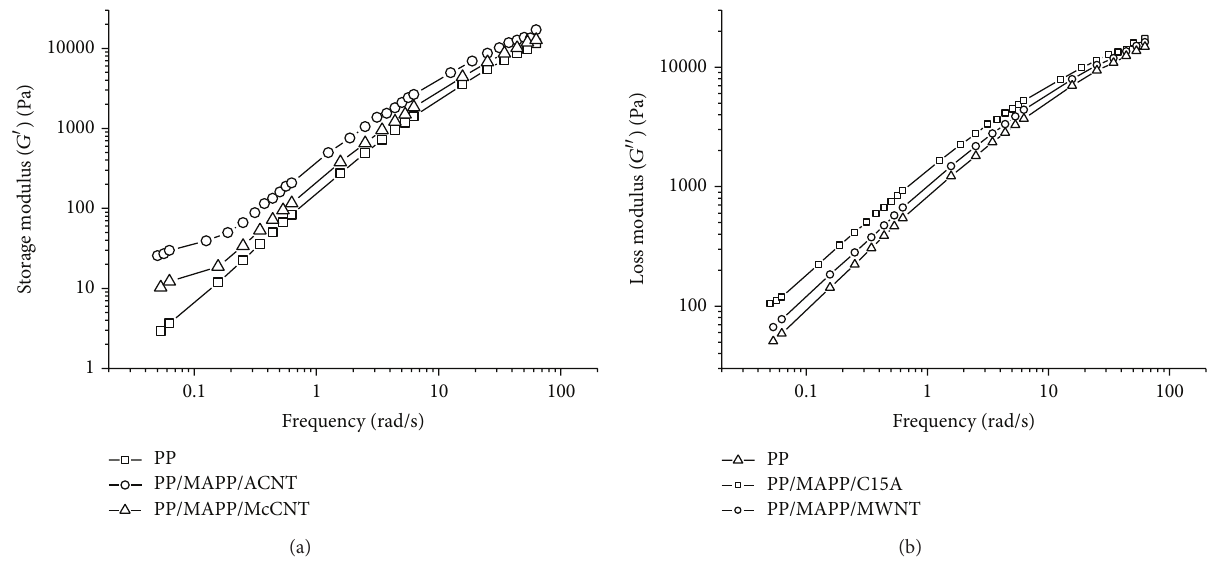
Figure 7: (a) Storage modulus versus frequency; (b) loss modulus versus frequency of PP and nanocomposites.